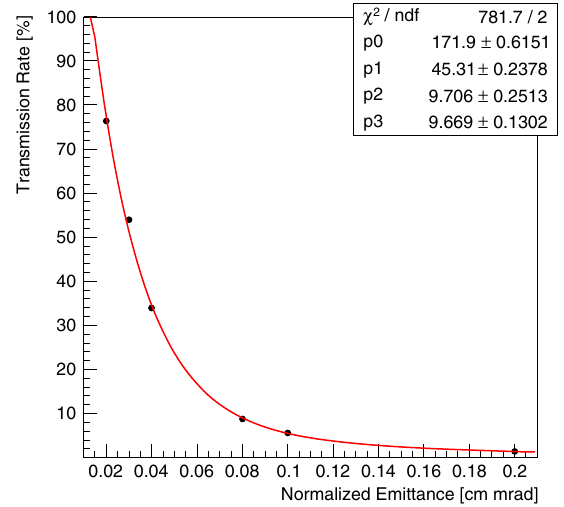
FIG. 17. Proton beam transmission rate as a function of normalized emittance. The horizontal and vertical axes represent the normalized emittance assumed in the simulation and the proton beam transmission rate through LEBT was evaluated by RFQGen simulation. The red curve depicts the fitting result with a function of f ð x Þ ¼ p 0 exp ð − p 1 x Þ þ p 2 exp ð − p 3 x Þ . transmission rate at the RFQ entrance position, respec- tively. Each circle denotes the data point obtained from simulation. The red line depicts the fitting curve of the function f ð x Þ : f ð x Þ ¼ p 0 exp ð − p 1 x Þ þ p 2 exp ð − p 3 x Þ .